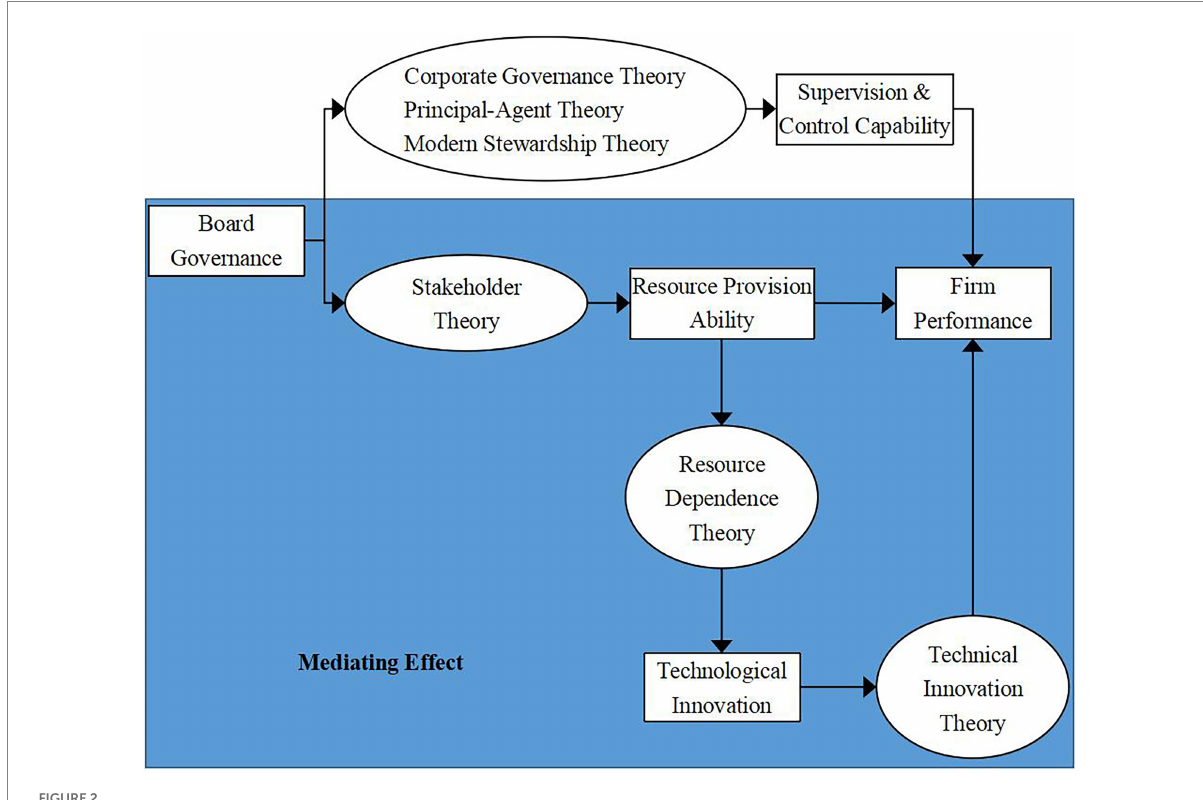
FIGURE 2 Theoretical